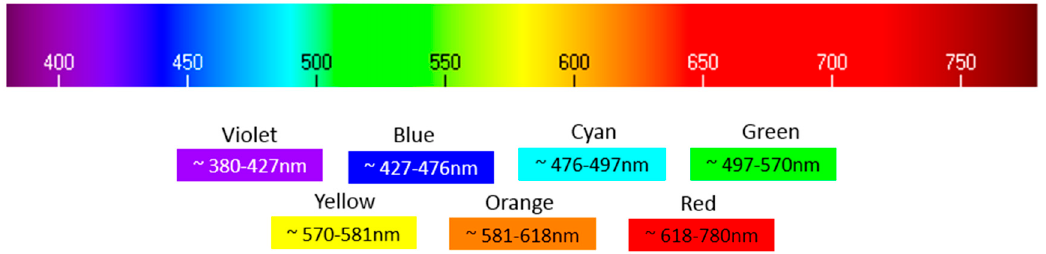
Figure 18. Visible light color spectrum. Table 3. Calibration straight lines between 427 and 480 nm